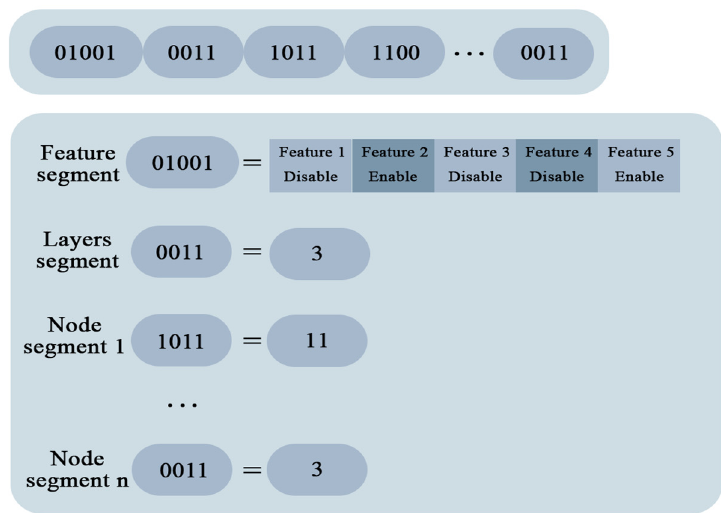
Figure 4. Gene Figure 4. Gene translation.